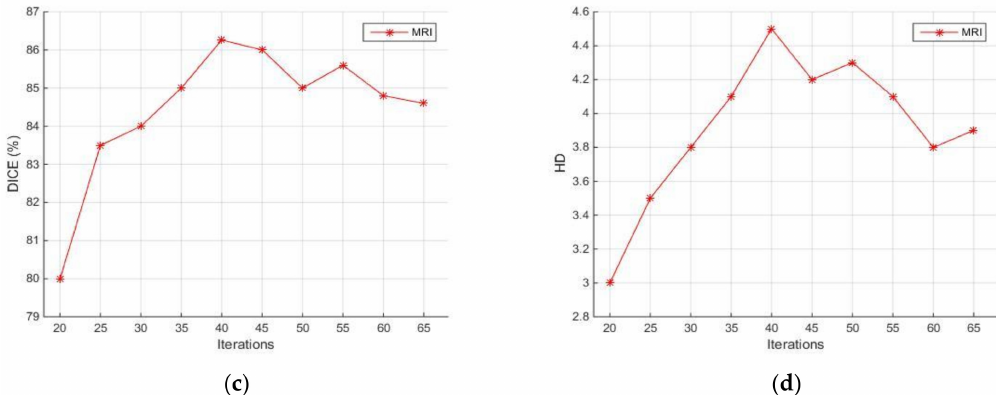
Figure 14. Sensitivity of segmentation quality with respect to DSC and HD against filter mask size ( a , b ) and active contour iterations ( c , d ). MR with red lines and CT with blue lines. The second parameter applies only to